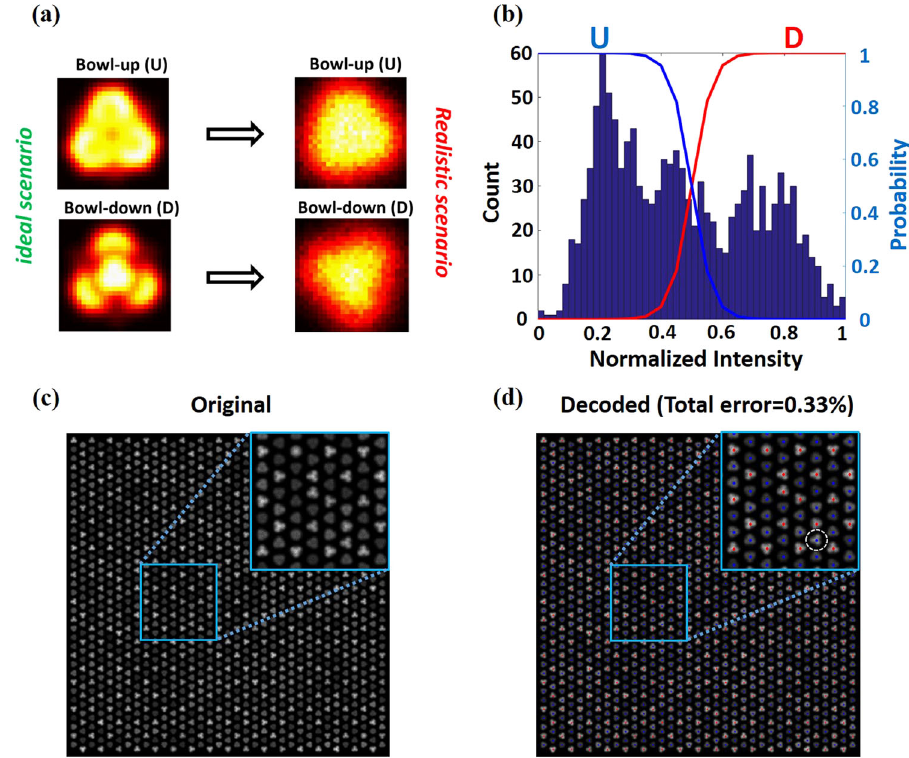
Fig. 3 Generating and analyzing synthetic data. a Schematics for generating synthetic data for each molecule. Left : DFT-simulated STM images of bowl-up and bowl-down con fi gurations. Right : Same images corrupted by admixing a proximate in energy azimuthal rotational state, blurring (effect of STM tip) and Poisson noise. b – d Application of graphical Markov model to synthetic data generated by Markov chain Monte Carlo sampler using inputs from density functional theory calculations of electronic charge density distribution in molecules. The number of molecules in synthetic dataset is 1225. b Intensity distribution for synthetic data. Two logistic functions overlaid (see text for details). c Real space distribution of molecules in synthetic dataset. d MRF based decoding of D and U states from image in c . The D and U states are denoted by red and blue, respectively. The total error (ratio of misidenti fi ed states) was 0.33 % or about 4 (out of 1225) molecules. One of the misidenti fi ed state is denoted by circle in the inset in